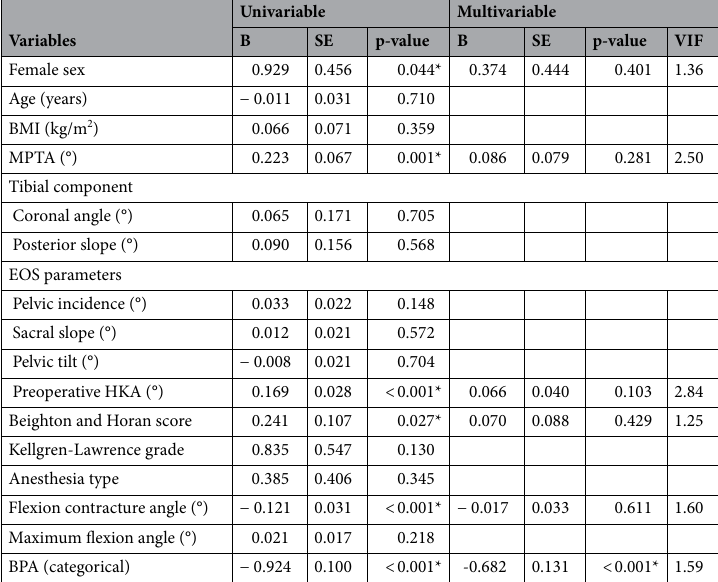
Table 3. Results of multivariable linear regression analysis for EG using categorical groups of BPA. Adjusted R 2 = 0.523. B regression coefficient, SE standard error, VIF variance inflation factor, BMI body mass